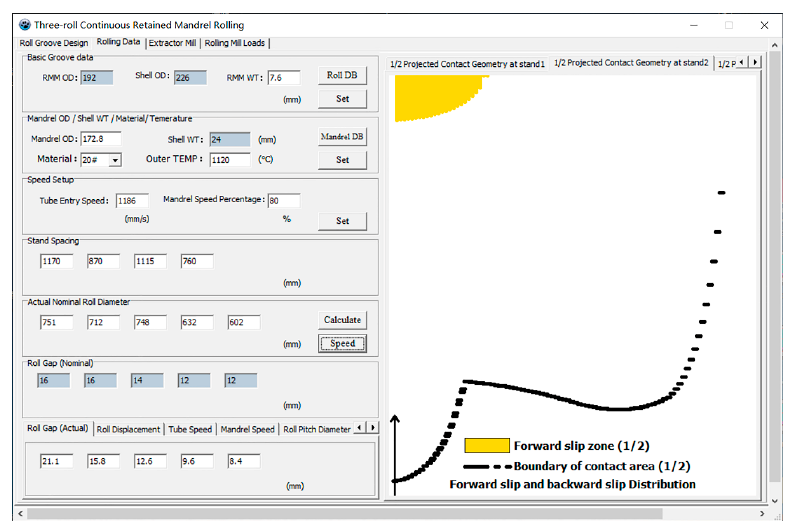
Figure 7. The visualized tube-roll contact boundary and metal slip distribution.